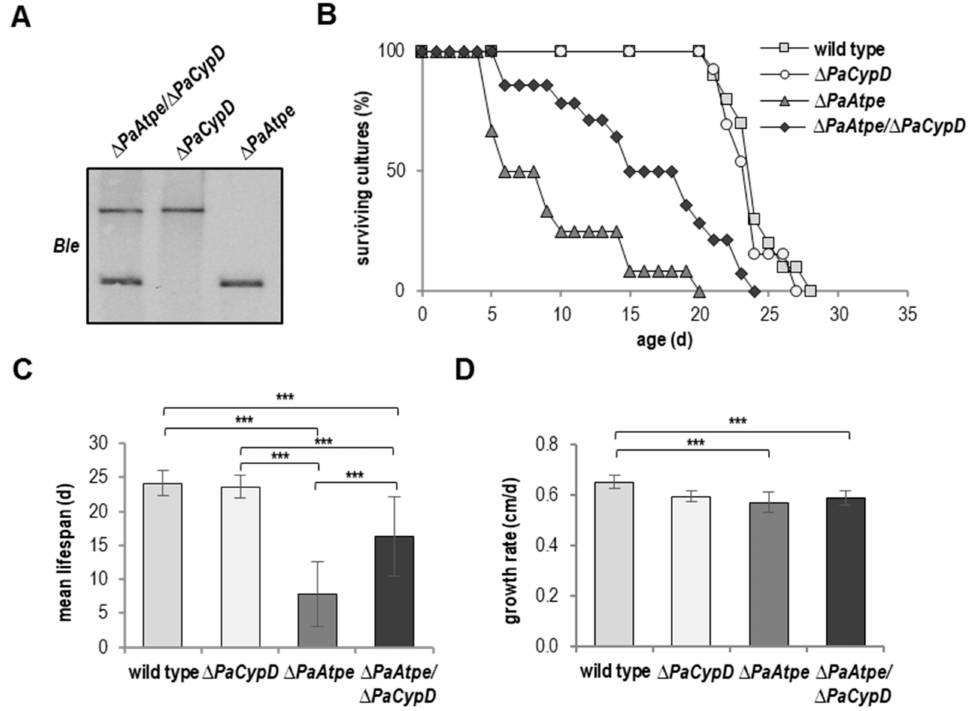
Figure 6. Deletion of PaCypD partially restores lifespan of the dimerization mutant. ( A ) Southern blot analysis verifies the newly generated double mutant ∆ PaAtpe/ ∆ PaCypD by the phleomycin ( Ble ) resistance genes ( B ) Survival curve of P. anserina wild type ( n = 10), ∆ PaCypD ( n = 13); ∆ PaAtpe ( n = 12; p = 0.00002) and ∆ PaAtpe/ ∆ PaCypD ( n = 14; p = 0.0004) grown on standard M2 medium. ( C ) Mean lifespan and ( D ) mean growth rates of cultures from (B). Error bars correspond to the standard deviation. The p -values of the survival curves were determined by SPSS with three different tests that for mean lifespan and growth rate by two-tailed Student’s t test. *** p <